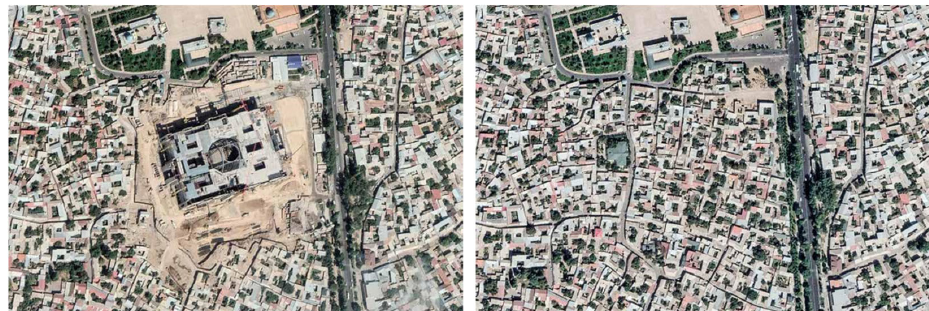
Figure 15. The imamate of Hazrat complexes disappeared during the expansion of the town [3]. 4.